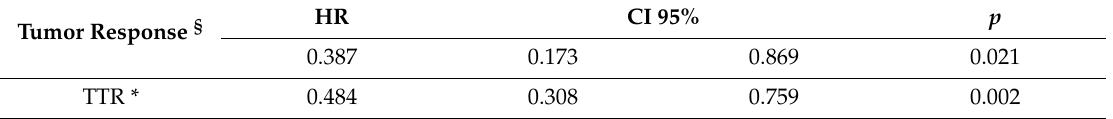
Table 5. Multivariate analysis with significant predictors of